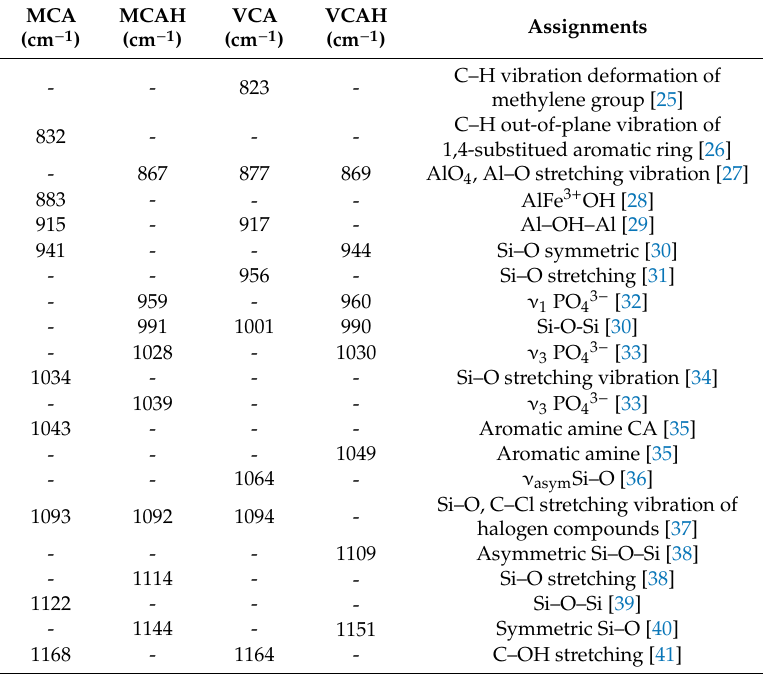
Table 1. FTIR bands associated with the functional groups present in all the